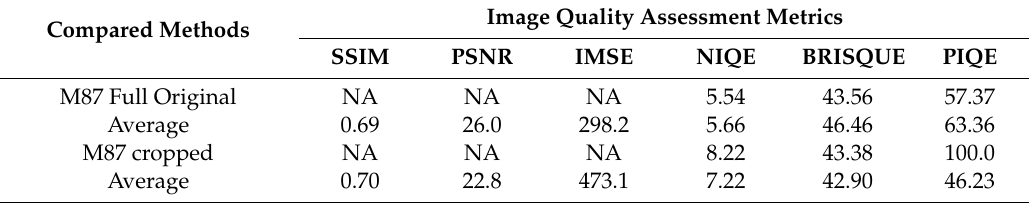
Table 3. Average values for image quality assessments (IQAs). SSIM: structural similarity index, PSNR: